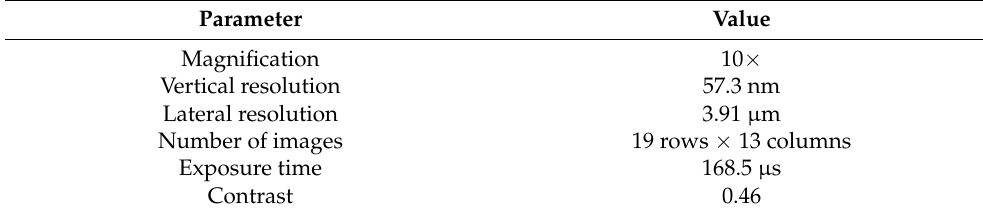
Table 4. Alicona G4 measurement device main